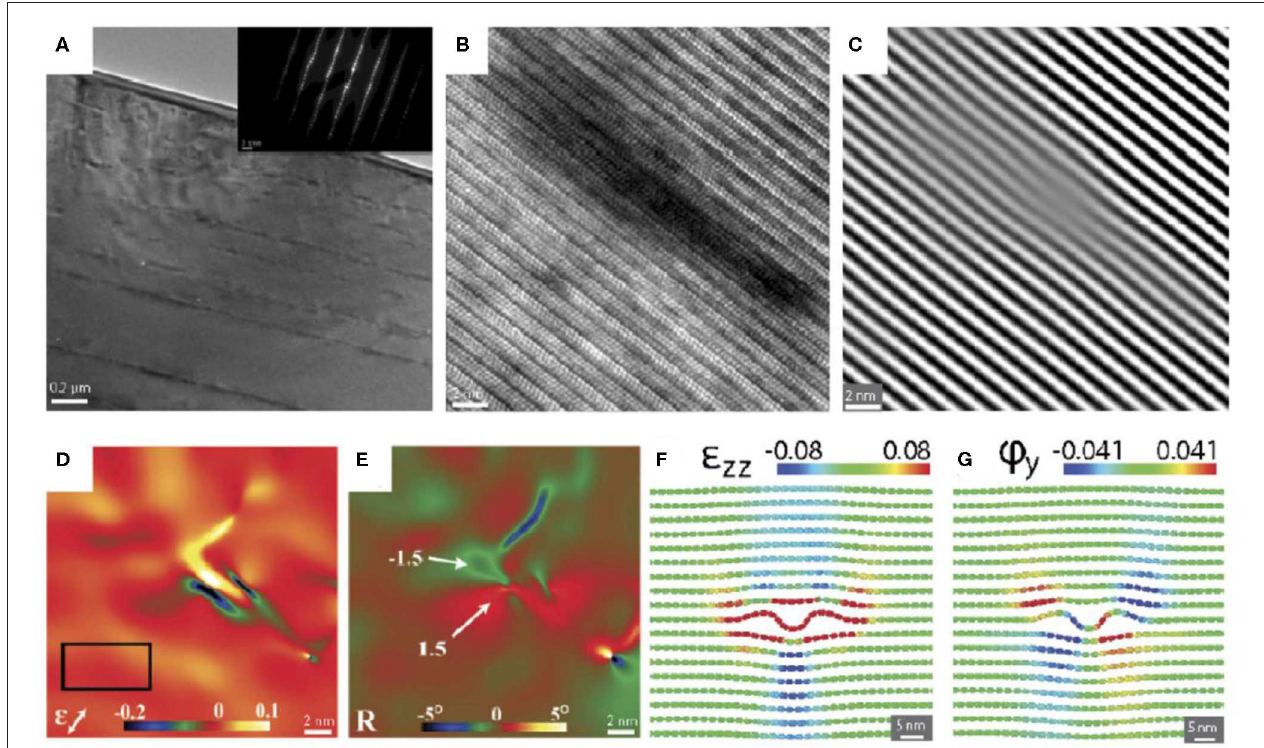
FIGURE 7 | TEM and strain analysis of Ti 3 SiC 2 : (A) typical TEM image of an indented Ti 3 SiC 2 grain normal to [0001], showing a high defect density. Inset shows diffraction pattern. (B) High resolution TEM image showing an individual ripplocation; (C) Fast Fourier transform of the same region shown in (B) where distortion of the basal planes is clearly visible. Geometric phase analysis is leveraged within this area to produce, (D) c-strain, ε zz , and, (E) basal plane lattice micro-rotation maps. The black box in (D) denotes the reference lattice for geometric phase analysis. These are similar to calculated fields of, (F) ε zz and, (G) micro-rotation in graphite determined from MD atomistic simulations. In all cases, the z-direction was normal to the basal planes. Reproduced under the Creative Commons CC BY license.